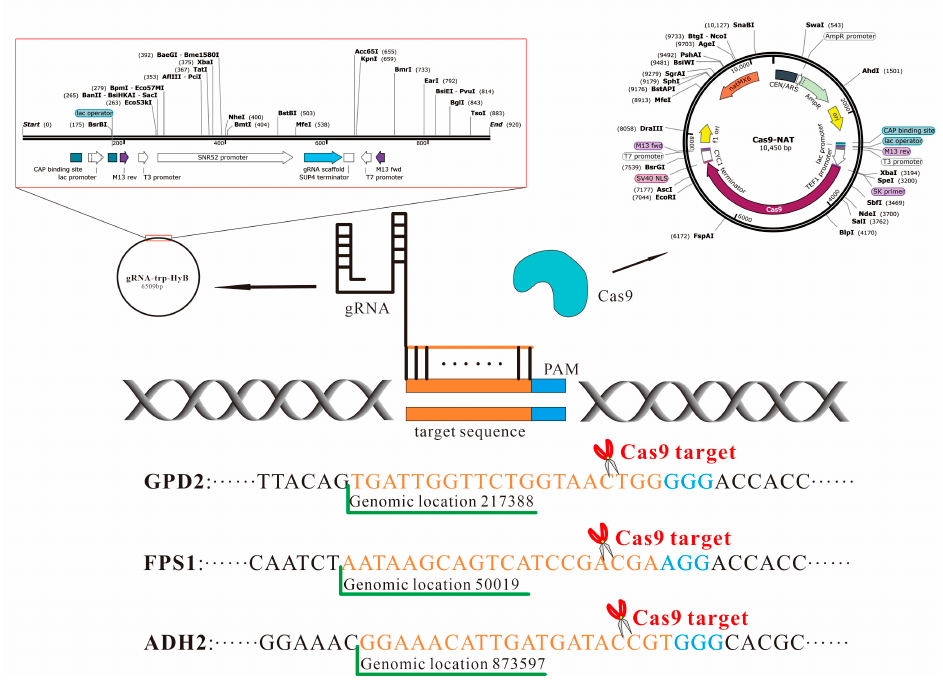
Figure 2. Gene knockout principle using the CRISPR-Cas9 approach. DNase expressed by Cas9-NTC cut off the genome DNA of S. cerevisiae under the guide of 20-bp gRNA expressed by vector gRNA-trp-HyB. The size of 20-bp gRNA was designed according to GPD2, FPS1, and ADH2 sequences. The recognition sequences of GPD2, FPS1, and ADH2 were marked in orange font.